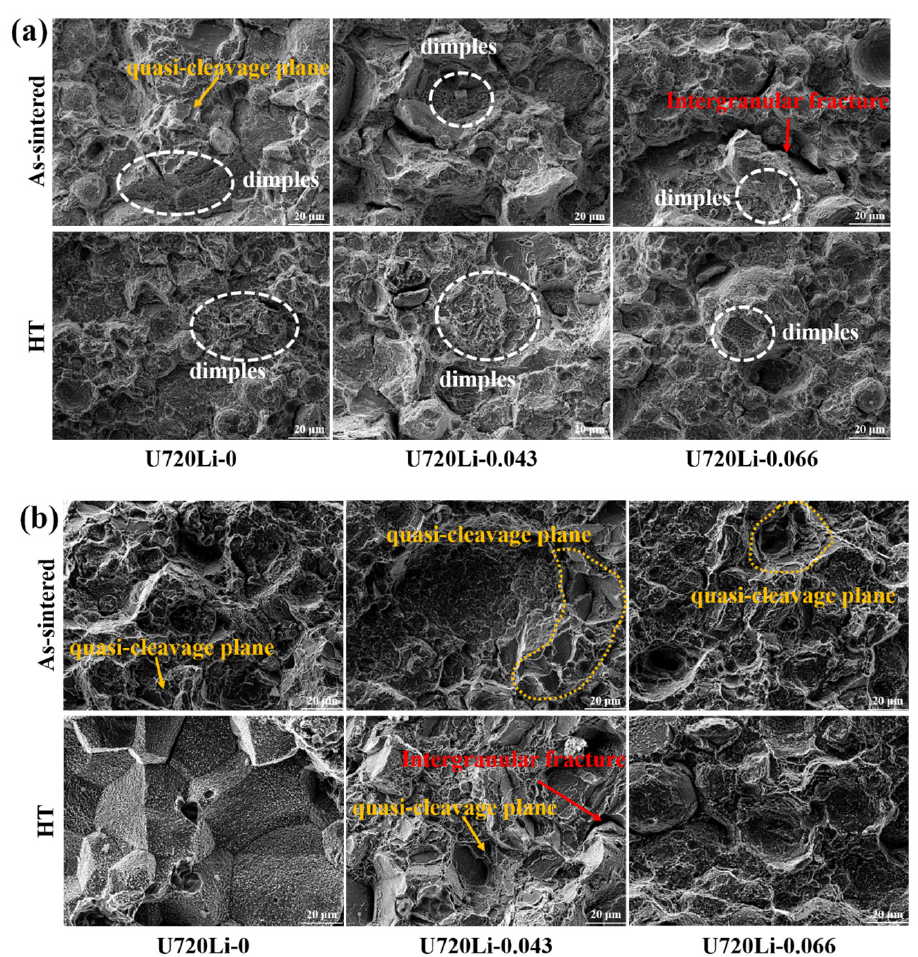
Figure 17. Fracture surface morphology of Sc-doped U720Li under different conditions: ( a ) 25 ◦ C, ( b ) 750 ◦ C.